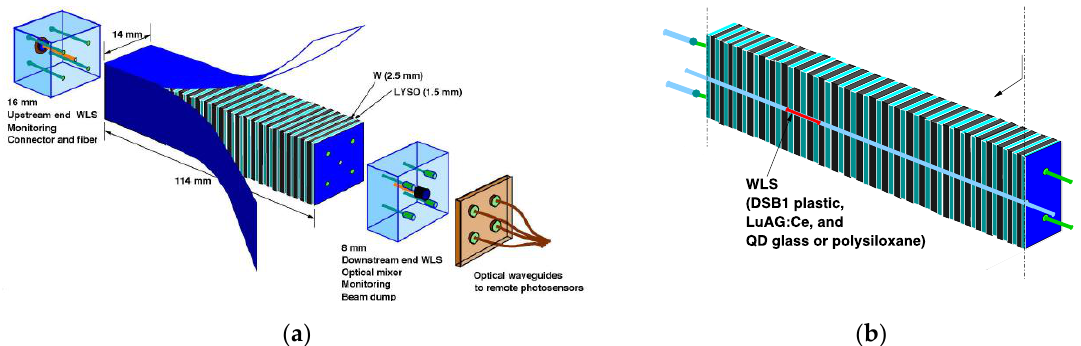
Figure 1. ( a ) Schematic of a RADiCAL module which is scaled to the Moliére radius of EM showers in a W/LYSO:Ce sampling calorimeter. The beam enters from the upper left and exits the lower right in this view. Light from the scintillation tiles is wave-shifted in capillaries or filaments that penetrate through the full length of the module to photosensors positioned at the ends of the module or remotely via fiberoptic waveguides. ( b ) A half-section of a RADiCAL module indicating two energy (E-type) capillaries penetrating the full length of the module and a timing (T-type) capillary superimposed to show its WLS filament (highlighted in red) positioned in the region of shower max for an EM shower.